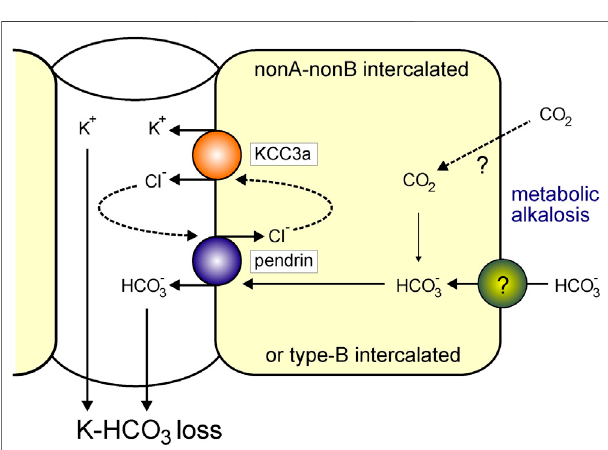
FIGURE 9 | KCC3a participates in K + loss in isolated alkalemia caused by metabolic alkalosis. Increased HCO 3 − with a consequent increase in blood pH is known as alkalemia. NonA/nonB and/or type-B intercalated cells express pendrin and KCC3a at the apical membrane. Pendrin and KCC3aareupregulatedduringbaseloadingormetabolicalkalosis.AsKCC3a secretes K + and Cl − and pendrin recycles Cl − in exchange for HCO 3 − , this leads to a net loss of KHCO 3